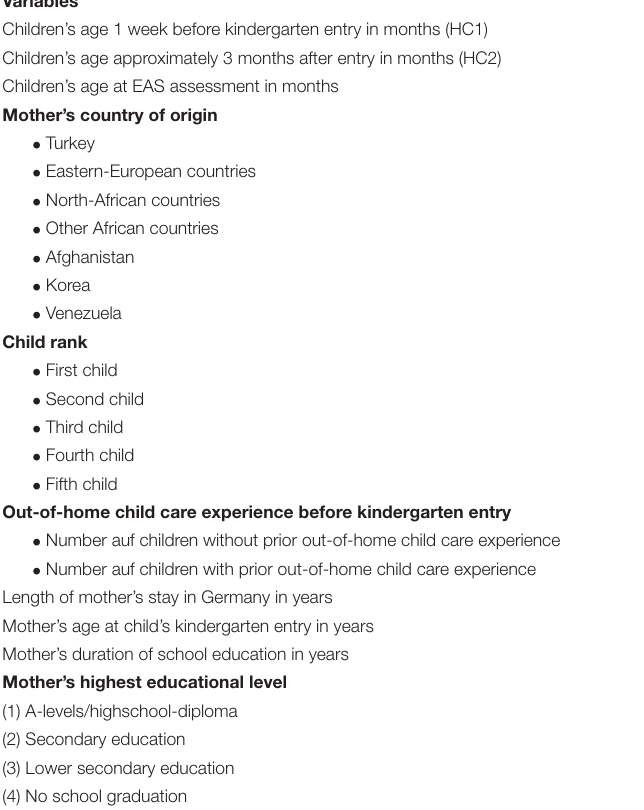
TABLE 1 | Sample description of N = 24 mothers and children.